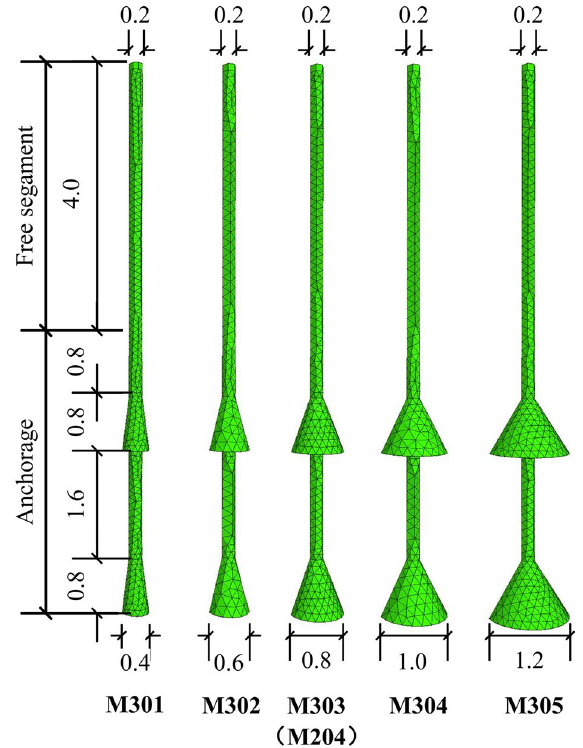
Figure 17. Diagram of group M3 anchors (Unit: m).